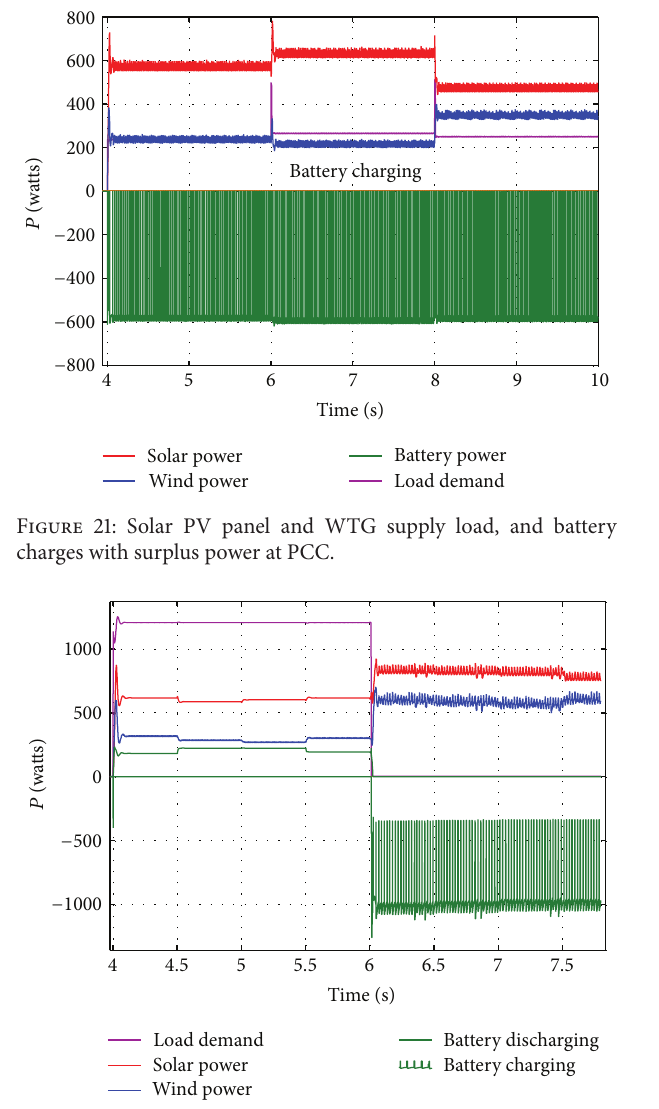
Figure 24: Controller duly connects the fuel cell along with the PV and WTG to supply the fixed